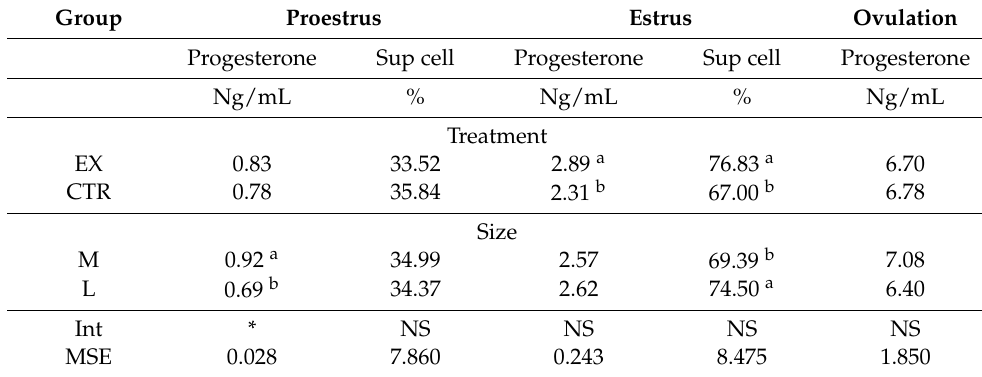
Table 3. Monitoring of bitches until pregnancy diagnosis: vaginal cytology and serum